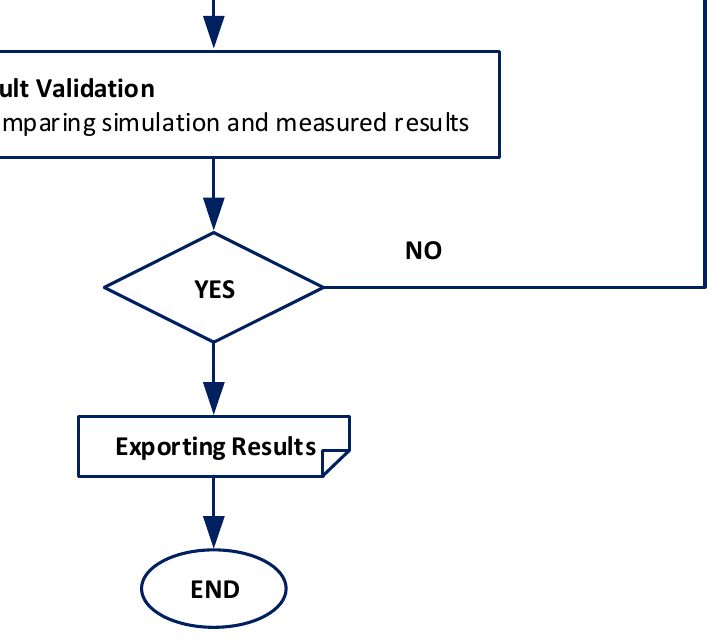
Figure 2. The workflow of the study